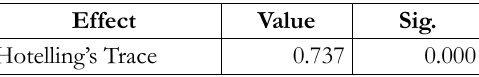
Figure 6. Result of correlation test